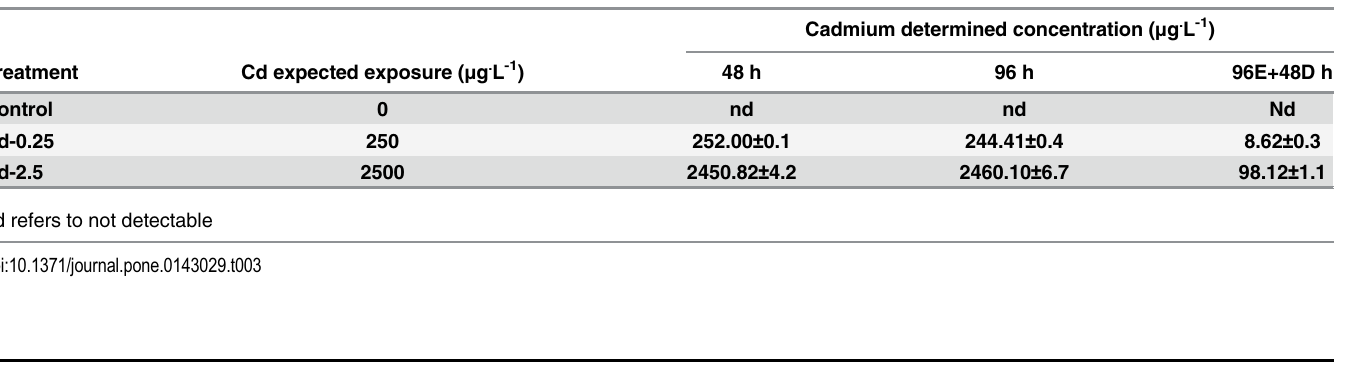
hours of exposure and positive correlations (cells labeled by PI and bud; and cells labeled by PI